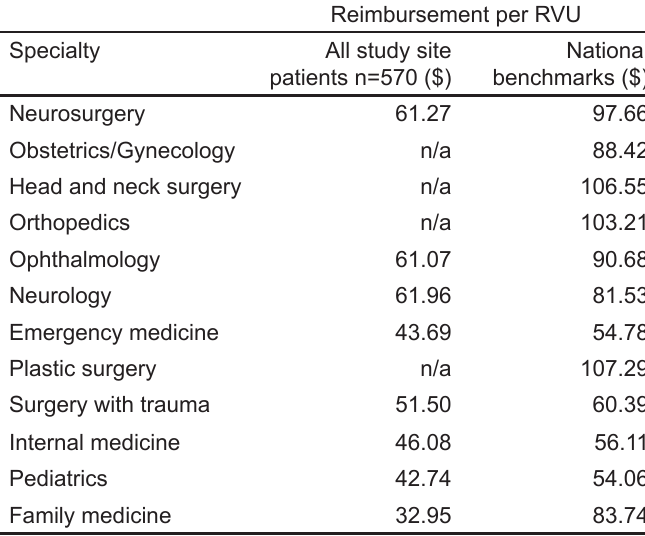
Table 2 . Reimbursement per RVU for all HLOC study site patients by specialty. National benchmarks of reimbursement per RVU from the 2006 MGMA Survey. Specialities are organized from highest to lowest according to reimbursement per RVU as in Table 1.